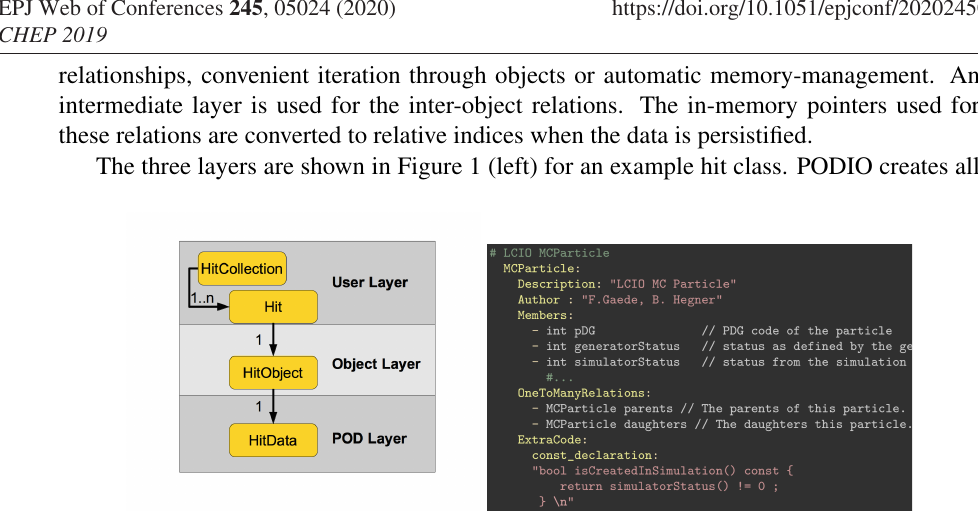
Figure 1. Left: the three layers of PODIO: the actual POD Layer with the data, the Object Layer for relations and on top the lightweight User Layer with handles and collections. Right: simplified example of a YAML file describing an MCParticle class with relations and additional C ++